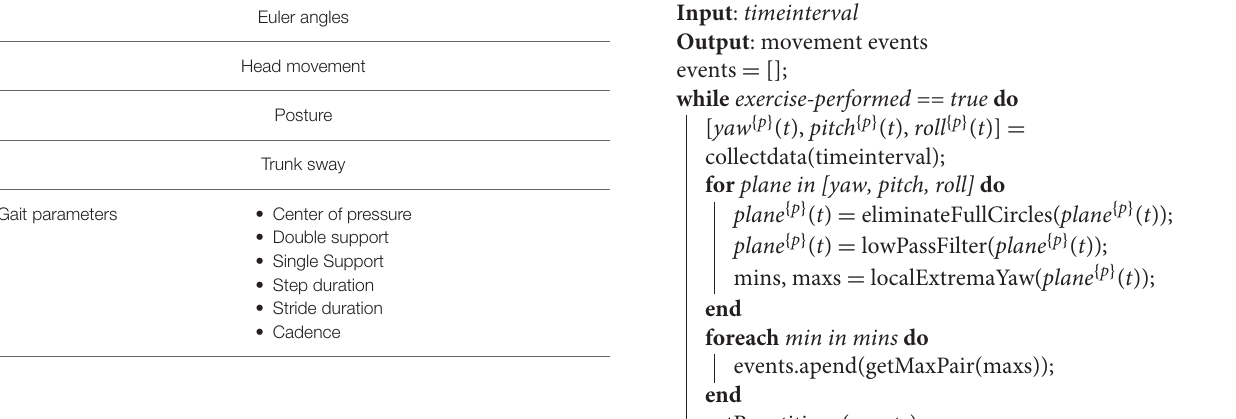
Algorithm 1: Head movement